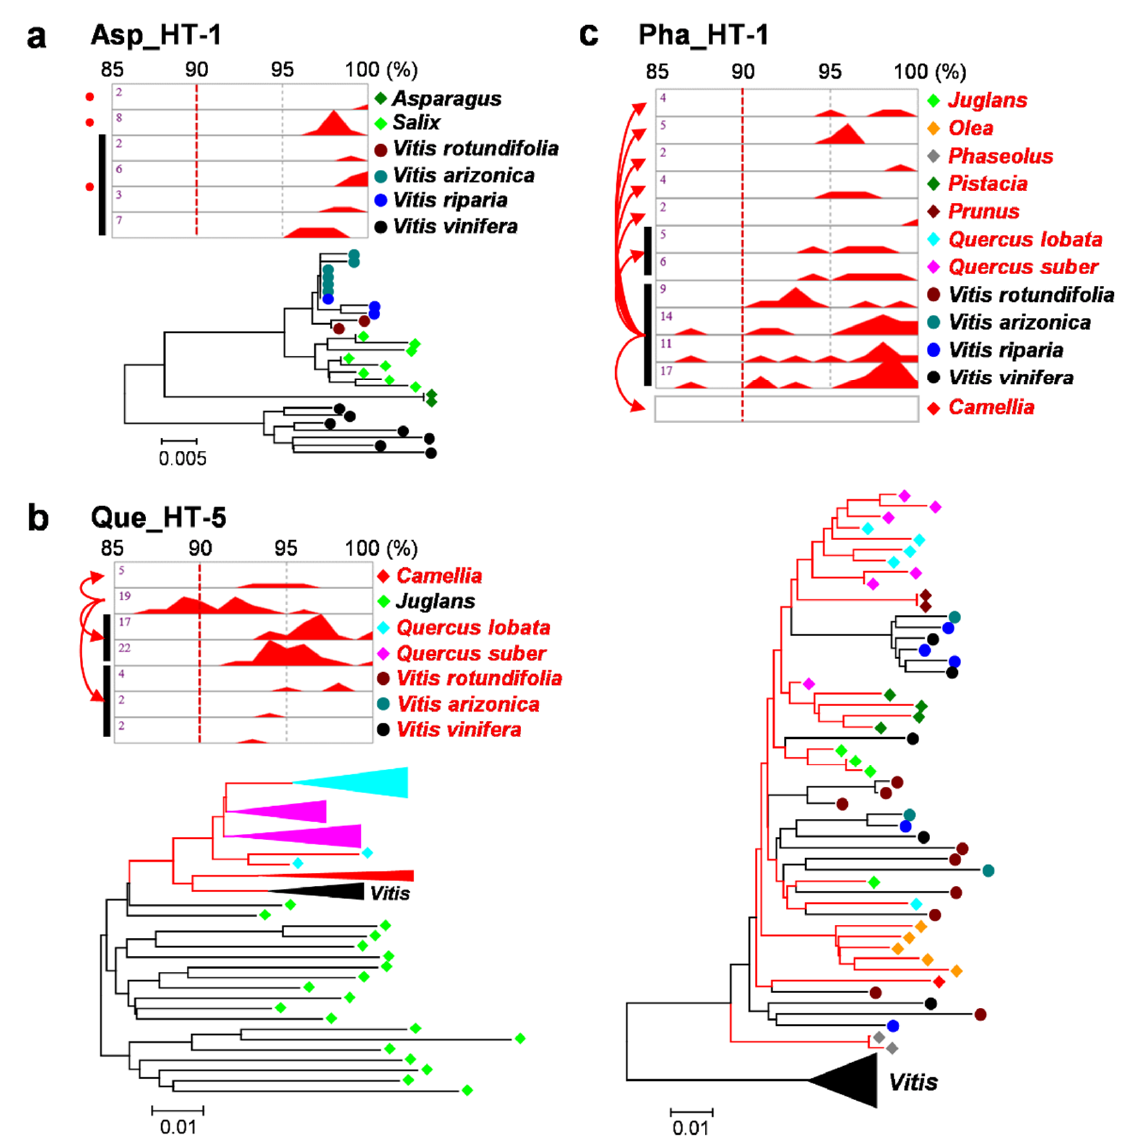
Figure 3. Three representative cases of HT validation. The panels represent cases of “undetermined donor and recipient” ( a ), “ Vitis as the recipient” ( b ), and “ Vitis as the donor” ( c ). ( a ) The activity history is shown in the upper panel. The name of the species or genus is shown on the right side of the panel. Each of the Vitis species is marked with a colored circle, and other non- Vitis species are marked with colored rhombuses. The percent identity is shown at the top of the panel. The red graph in each square represents the relative activity history of the paralogs of the horizontally transferred TE. The numbers in the panel indicate the number of paralogs used in each species. The species in the same genus are marked with black bars on the left side of the panel. The red dots indicate the species or genera for which the donor or recipient was undetermined. The dotted red lines present the 90% identity threshold used in the identification of HTs. The lower panel presents the phylogenetic tree of the homologs of the horizontally transferred TE. The species or genus of each element is marked with the same colored circle or rhombus used in the activity history panel. ( b ) In the activity history panel, the red arrows on the left reveal the direction of HT. In the phylogenetic tree, the branches of recipients are marked with red lines. The colored triangles in the phylogenetic tree represent the merged clusters of the same species or genus. The triangles of the species or genera, except for Vitis , are presented in the same color used in the activity history panel. The Vitis genus is presented with a black triangle. The rest are the same as in ( a ). ( c ) In the activity history panel, the species that contains a single-copy homolog is presented with an empty square at the bottom of the panel. The rest are the same as in ( a , b